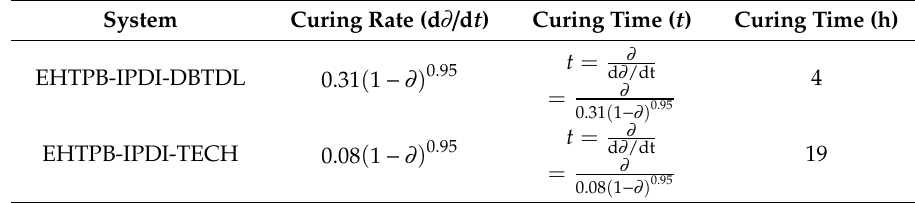
Table 7. Analytical expressions for curing rate and curing time, and the values of the curing time of the EHTPB-IPDI-DBTDL and EHTPB-IPDI-TECH